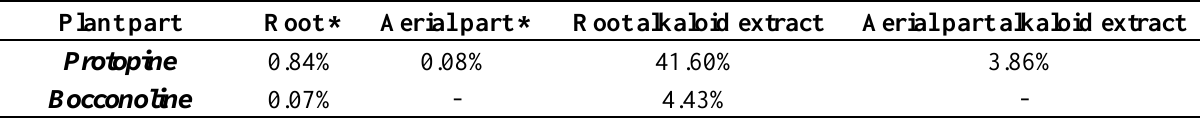
Table 1. Content (%) of alkaloids 2 (protopine) and 6 (bocconoline) in G. flavum root and aerial